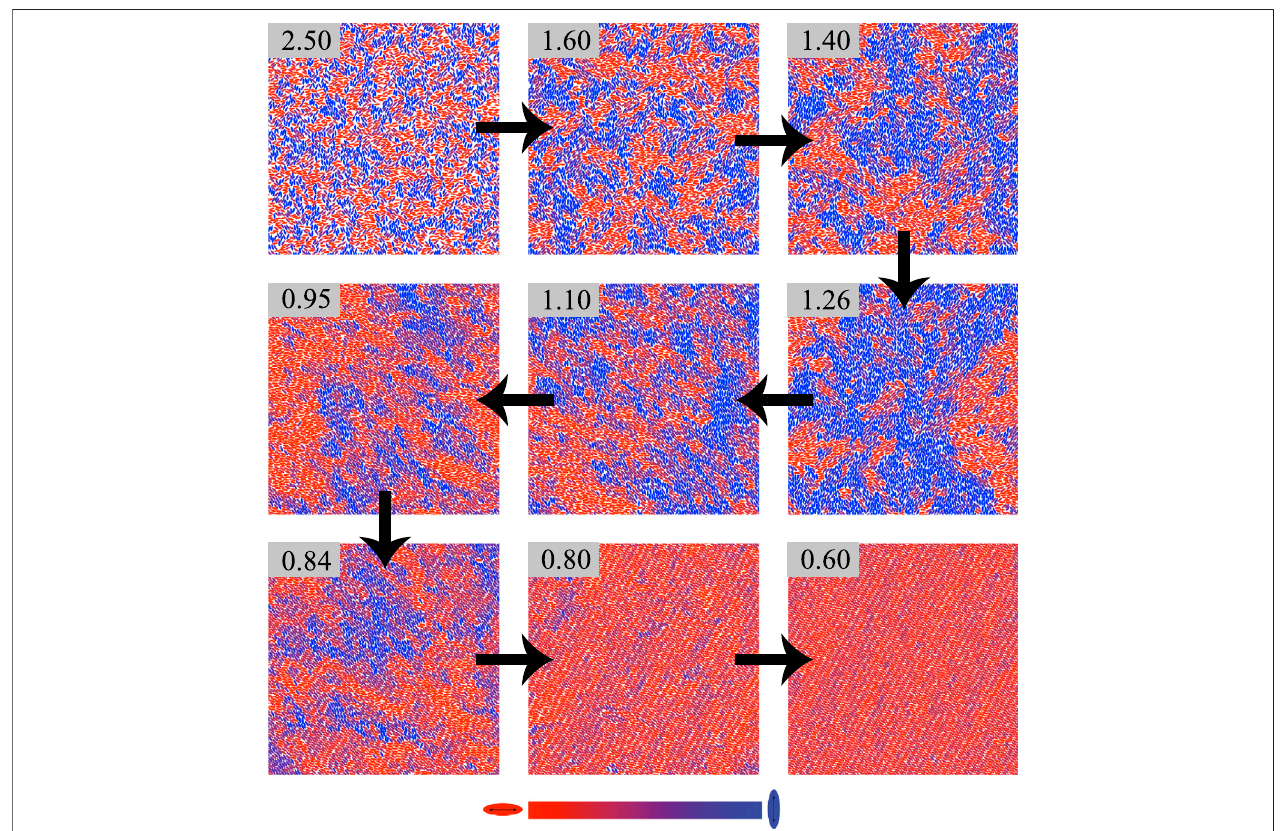
FIGURE 4 | Snapshots of the bulk 2D system when P p (cid:2) 5 . 0 and N (cid:2) 50 , 000. Shown is an eightfold-magni fi ed region of the ensemble to discern the local order of mesogens. Con fi gurations are arranged as a temperature sweep (arrows) with each con fi guration showing its temperature T p . Mesogens are colored according to orientation, as indicated by the color bar